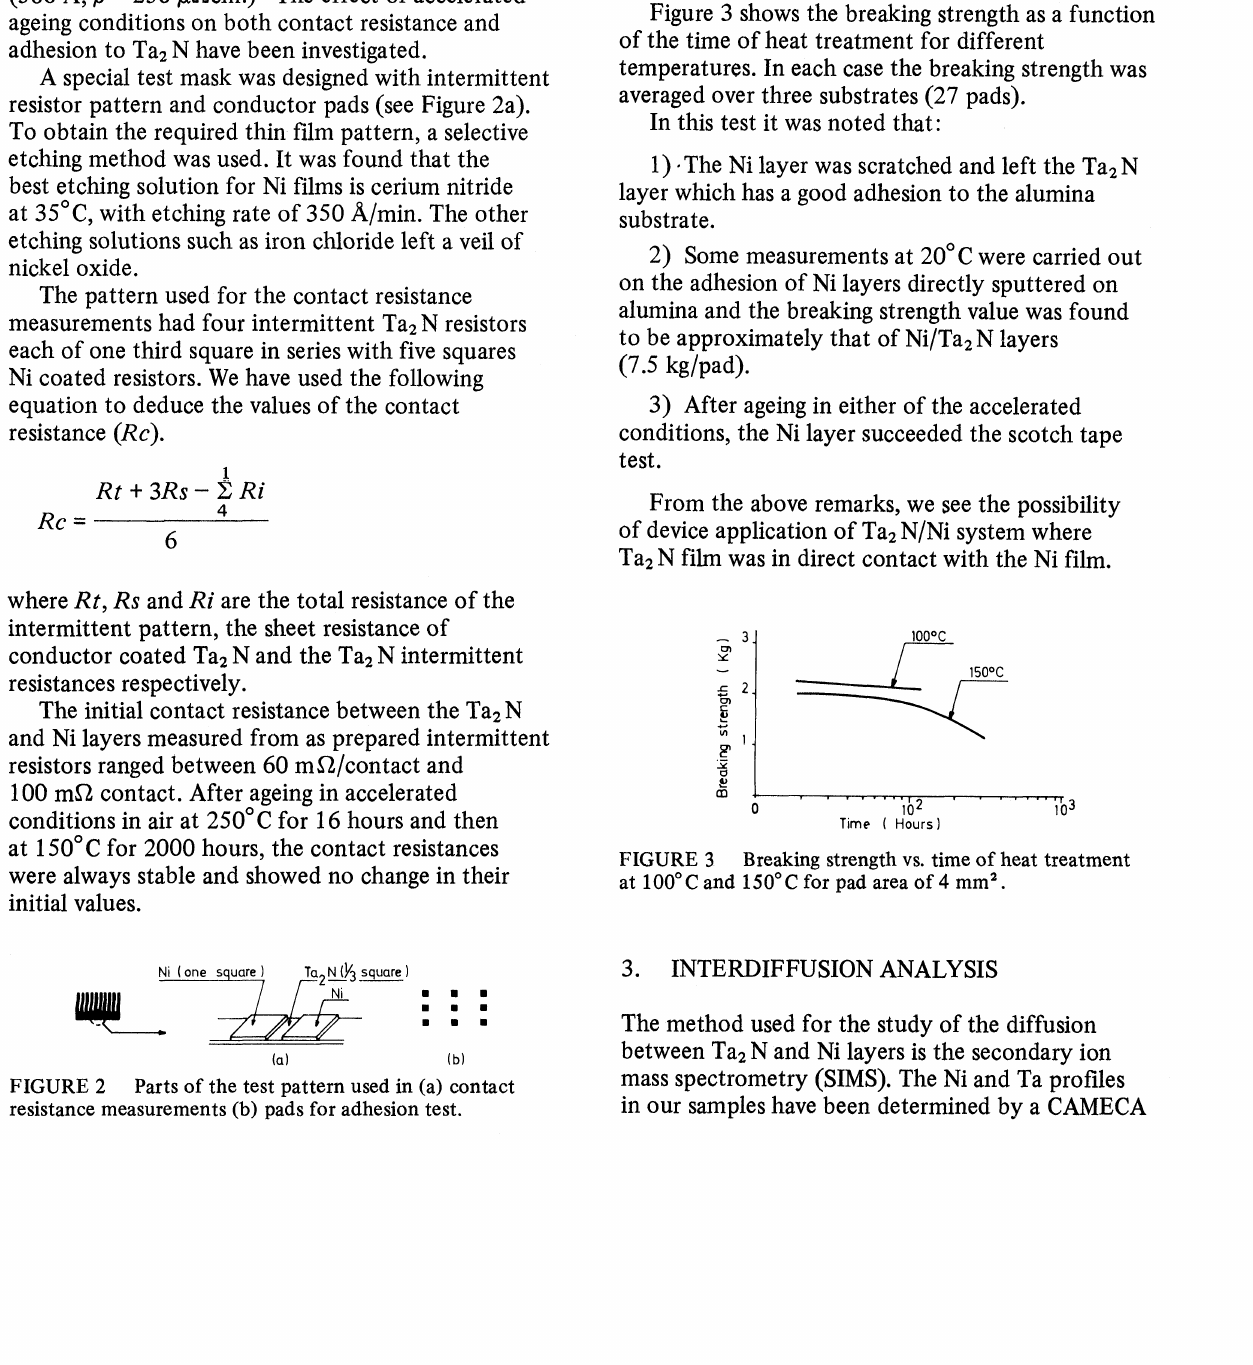
Breaking strength vs. time of heat treatment at 100C and 150C for pad area of 4 mm